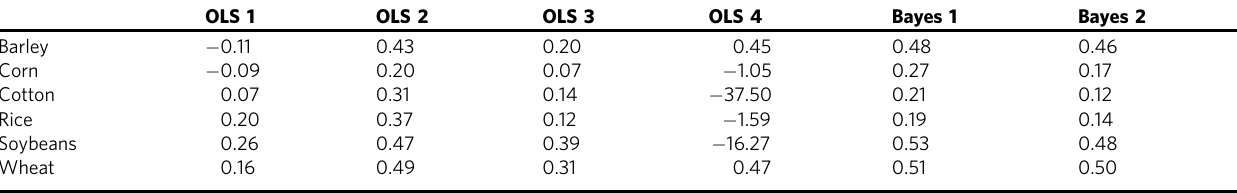
Table cells show R 2 by crop and model speci fi cation, using all data (top) and under cross-validation on 1995 – 2009 (bottom). The fi rst four columns are ordinary least-squares (OLS) speci fi cations, variously including region-speci fi c intercepts and covariate interactions. The last two columns are for the Bayesian model, with partially pooled intercepts and coef fi cients, either allowing each county to have a different variance (Bayes 1) or constraining all to have the samevariance (Bayes 2). In all cases, R 2 ¼ 1 (cid:2) OLS and the posterior prediction for the mean MCMC parameter draw for the Bayesian model, and (cid:2) y i is the average across all observations of y i